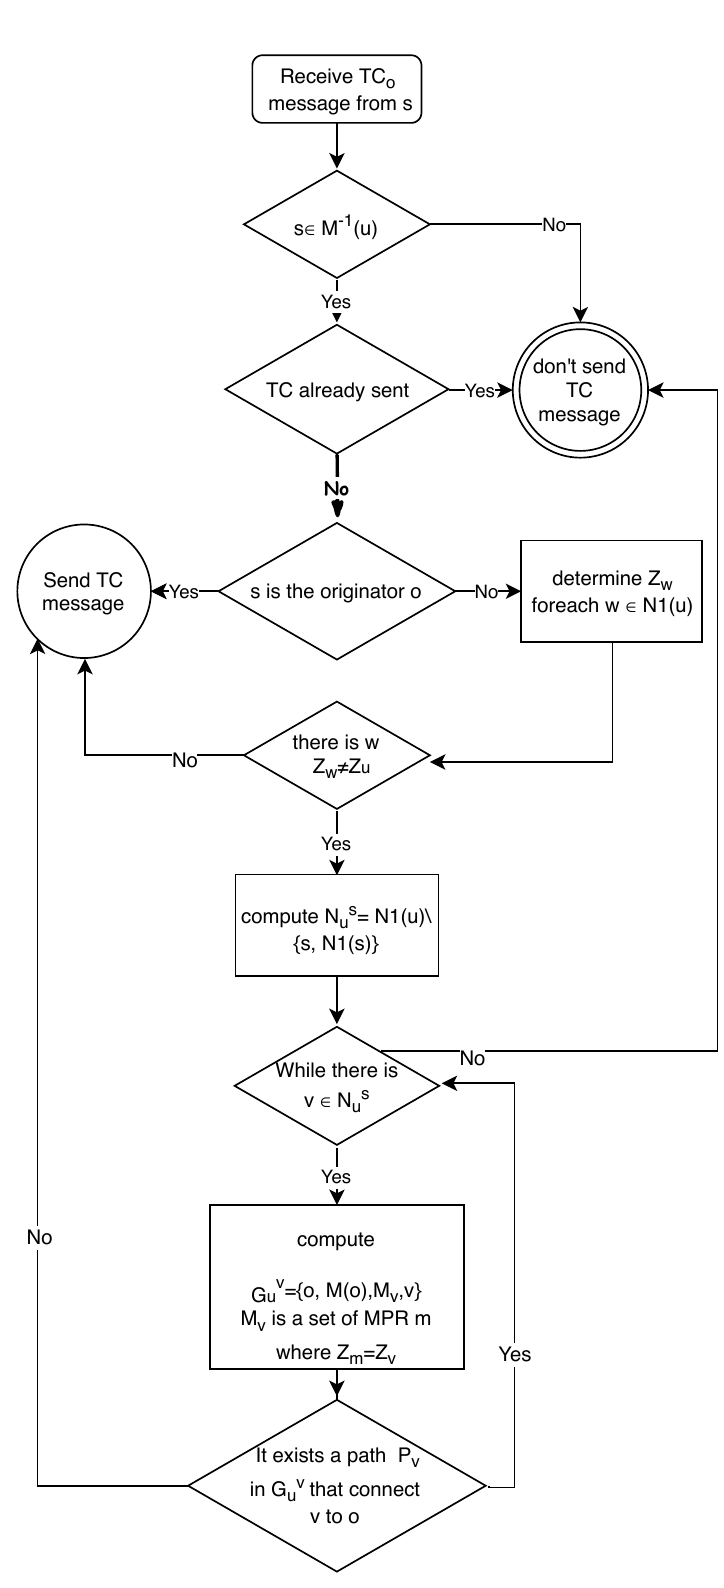
Figure 11. Geographic forwarding rules of